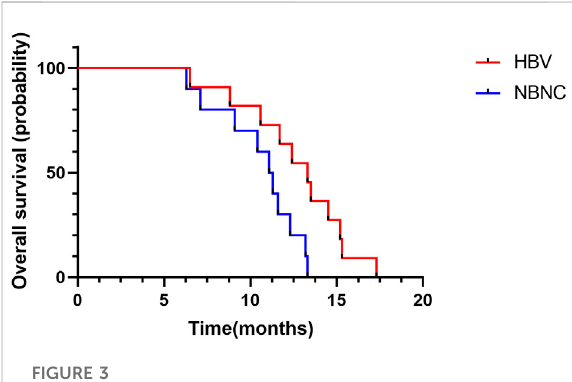
FIGURE 3 Kaplan – Meier plot of overall survival in the HBV – HCC and NBNC – HCC